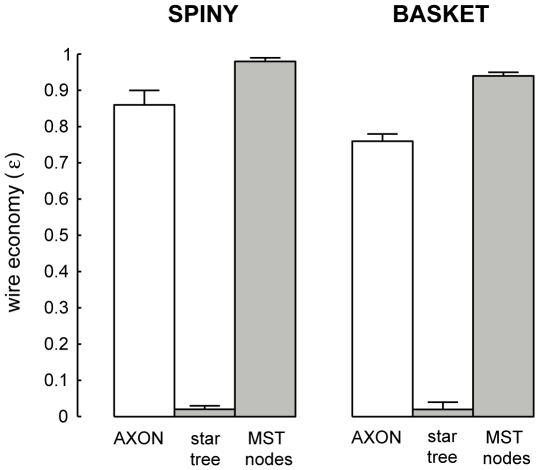
Wire length economy of individual spiny and basket cell intracortical axon arbors was suboptimal.Wire length economy (ε) of spiny and basket cell intracortical axon arbors (εAXON = LMST/LAXON, where LAXON is total axon arbor length based on direct distances between boutons) compared with path length optimized star graphs (εSTAR = LMST/LSTAR) and MST with additional vertices from axon bifurcations or nodes (εMSTnodes = LMST/LMSTnodes).